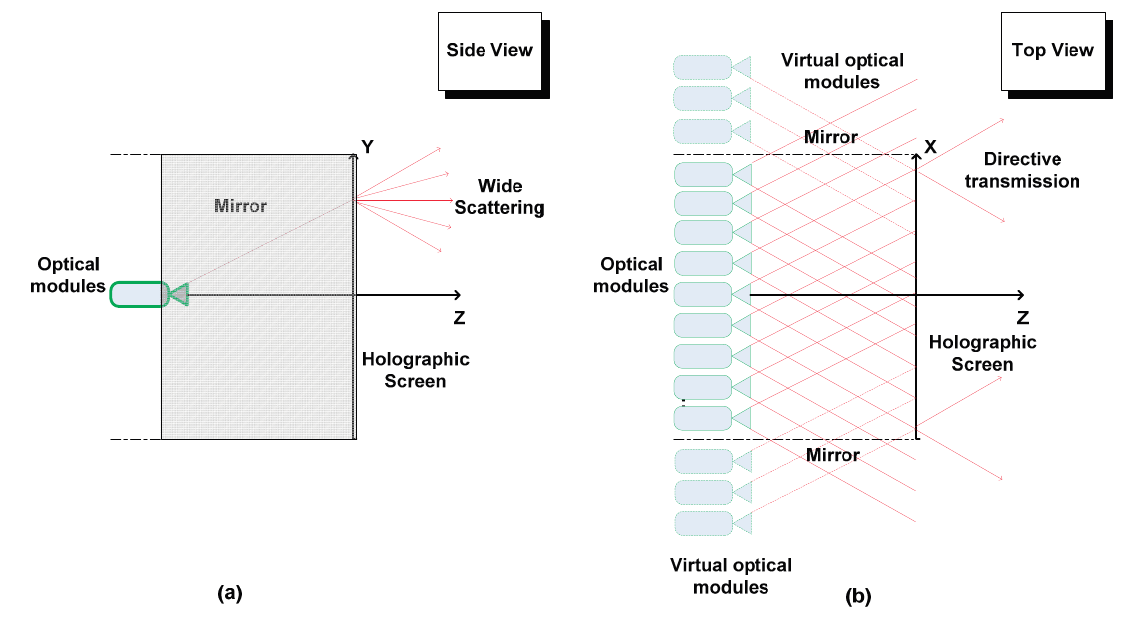
Figure 4. Main components of a light field display: geometrically aligned multiple optical modules, a holographic screen and side mirrors which help in increasing the field of